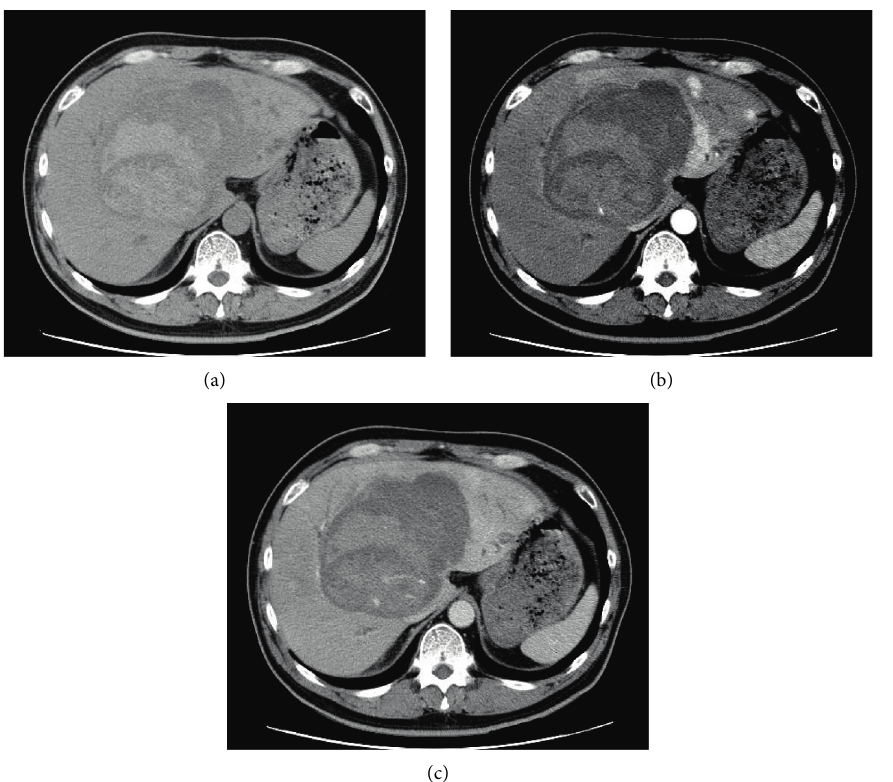
Figure 1: (a) Plain abdominal CT showing an irregular high-density area in the center of the liver and bleeding is suspected. Tumor detection is difficult. (b) Contrast-enhanced CT (arterial phase) revealing multiple tumors with a contrast effect in the left lobe of the liver (arrow). The patient was diagnosed with tumor-associated hemorrhage. (c) Abdominal CT (late phase) disclosing that the tumor exhibits the same contrast effect as normal liver tissue.